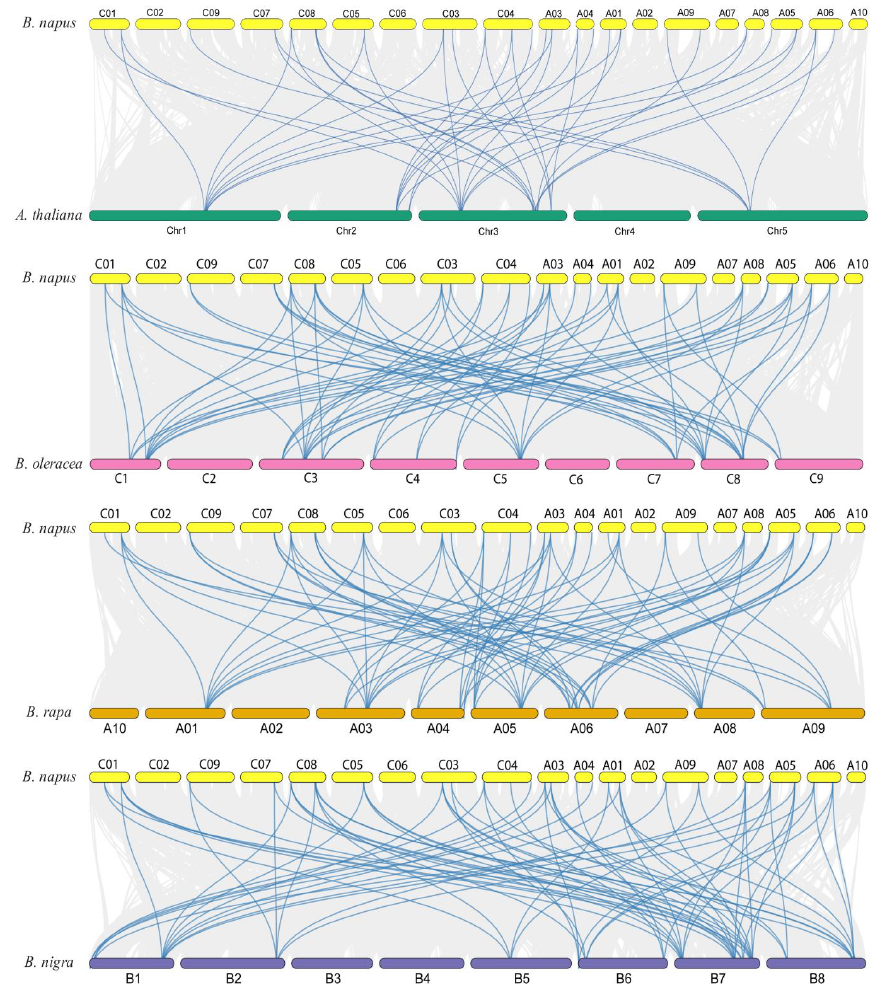
Figure 5. Collinear pair prediction of BnaCRKs among B. napus and four representative plant species. Gray lines in the background represent the collinear blocks within B. napus , A. thaliana , B. oleracea , B.rapa , and B. nigra , whereas blue lines indicate collinear pairs of BnaCRK s.